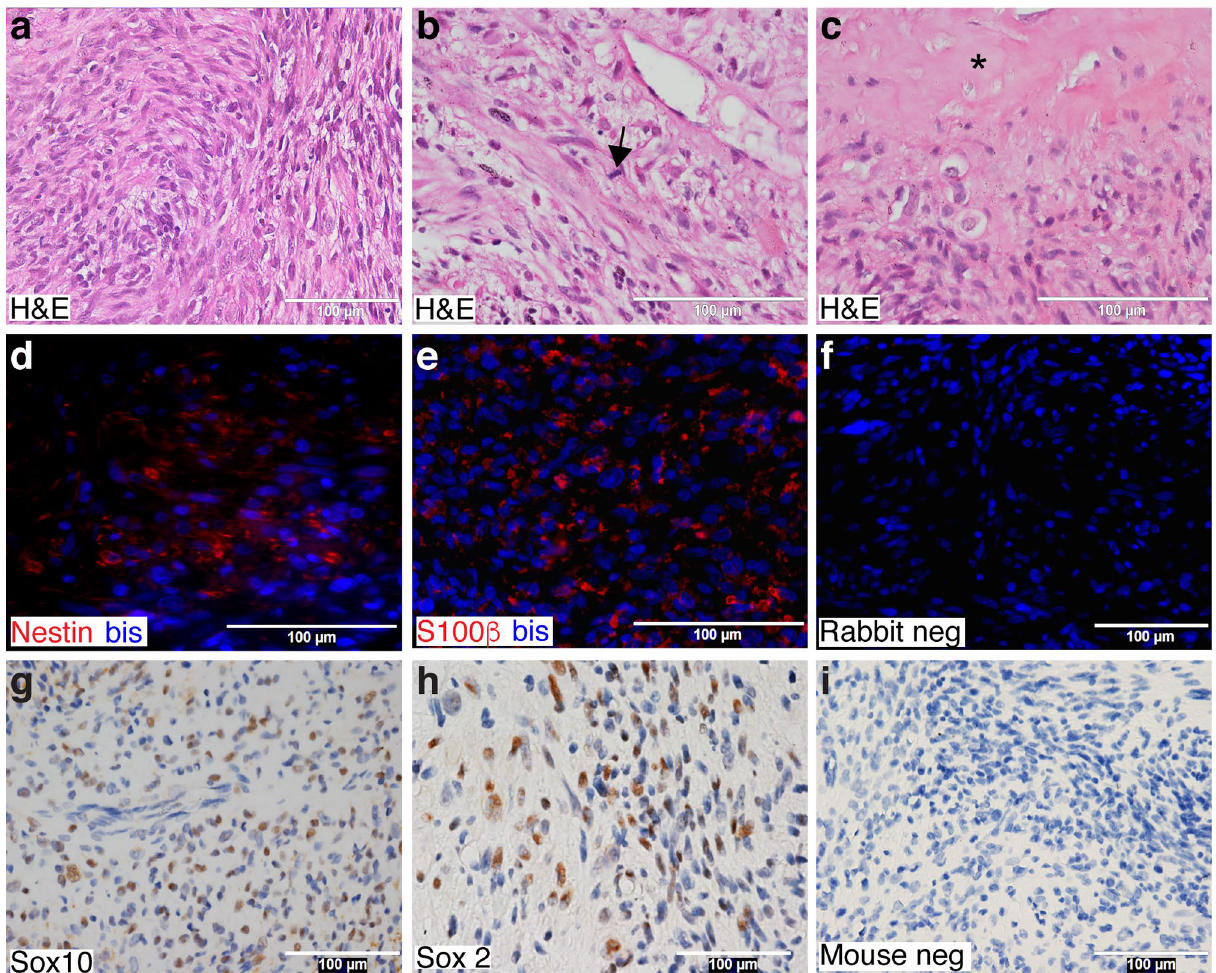
Figure 1. Pathology of the sporadic MPNST from which the 2XSB cell line was derived. ( a ) A representative hematoxylin and eosin (H&E) stained image (×40) displaying the densely packed, poorly differentiated cells composing this tumor. ( b , c ) High power (×60) H&E stained images highlighting high grade pathologic features such as mitotic figures (arrows, b ) and necrosis (asterisk, c ). ( d–f ) Representative immunohistochemical staining images of Schwann cell markers in formalin-fixed paraffin-embedded (FFPE) tumor tissue. Immunofluorescence staining highlights immunoreactivity for the intermediate filament nestin ( d , red) and the calcium binding protein S100β ( e , red), while immunoperoxidase staining shows nuclear immunoreactivity for the transcription factors Sox10 ( g , brown) and Sox2 ( h , brown). Non-immune rabbit (for S100β, Sox2) and mouse (for Sox10, nestin) IgGs were used as negative control primary antibodies ( f and i , respectively). Bisbenzimide (“Bis”, blue) was used as a nuclear counterstain in ( d )–( f ). Hematoxylin was used as a nuclear counterstain in ( g ) to ( i